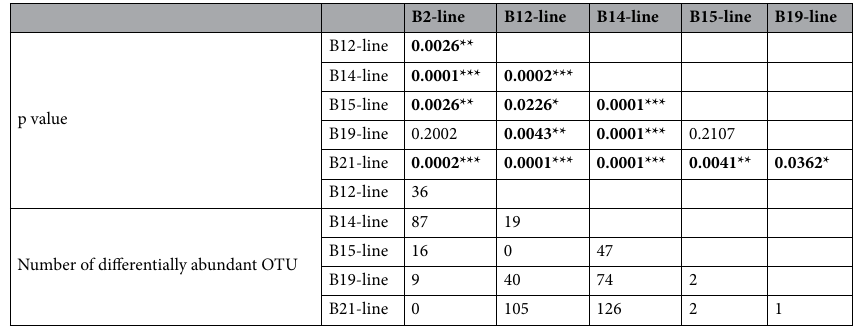
Table 2. Microbial dissimilarity between each couple of lines of laying hens one week after their infection with IBV. Microbial dissimilarity was assessed with Adonis test performed on Bray–Curtis distances between each couple of lines, and the corresponding p-value are reported in the table, and highlighted in bold letter when significant (*< 0.05. **< 0.01. and ***< 0.001). The whole population (vaccinated and challenged V-Ch, and non-vaccinated and challenged NV-Ch) was considered (n = 93). The vaccine status was set as main effect in the Adonis model for the analysis on the beta-diversity, and in the zero-inflated Gaussian mixture model from MetagenomSeq R package for the differential analysis on OTU abundance. Corresponding Supplementary Table S6 provide results of the differential abundance between each couple of lines.